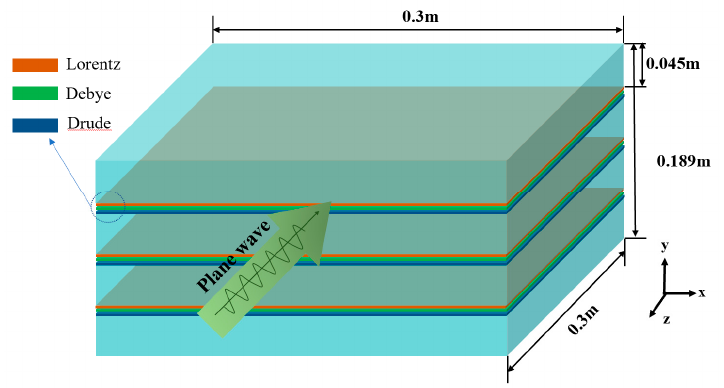
Figure 3. The specific structure of the dispersion plate.